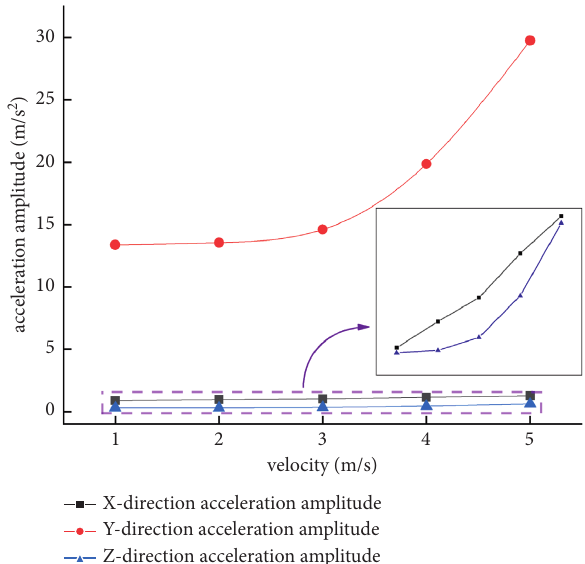
Figure 12: Variation curve of acceleration amplitude in different directions with natural gas